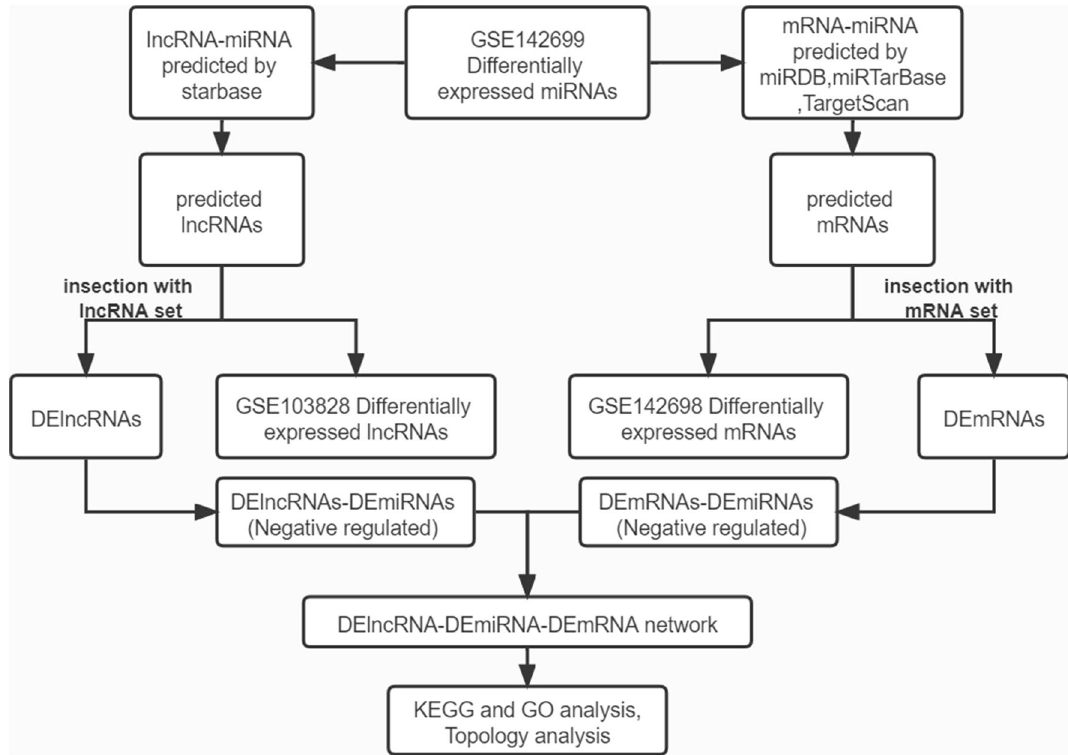
Figure 1. The flowchart for reconstruction of the lncRNA–miRNA–mRNA network. First, miRNA/lncRNA/ mRNA expression data were downloaded from NCBI GEO. Second, differentially expressed miRNAs (DEmiRNAs), lncRNAs (DElncRNAs) and mRNAs (DEmRNAs) were screened. Third, target mRNAs of DEmiRNAs were predicted using miRDB, miRTarBase and TargetScan databases. And target lncRNAs of DEmiRNAs were predicted using starbase database. Then, DElncRNAs and DEmRNAs were merged with the target lncRNAs and mRNAs of DEmiRNAs, respectively. The co-expression lncRNAs and mRNAs were selected. Finally, the DEmiRNAs, co-expression lncRNAs and mRNAs were mapped into the interactions.